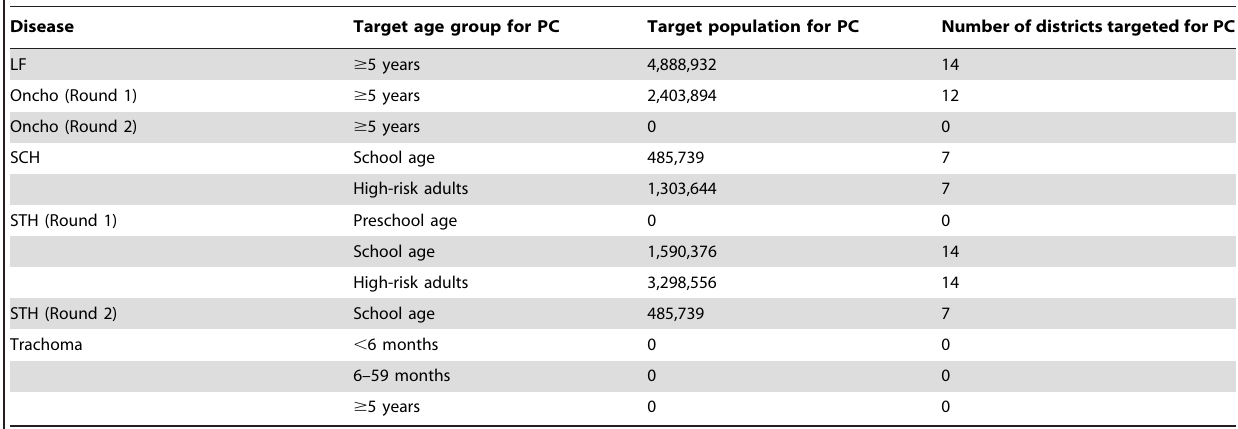
Table 2. Sierra Leone base data (FY Oct. 2010–Sept. 2011).